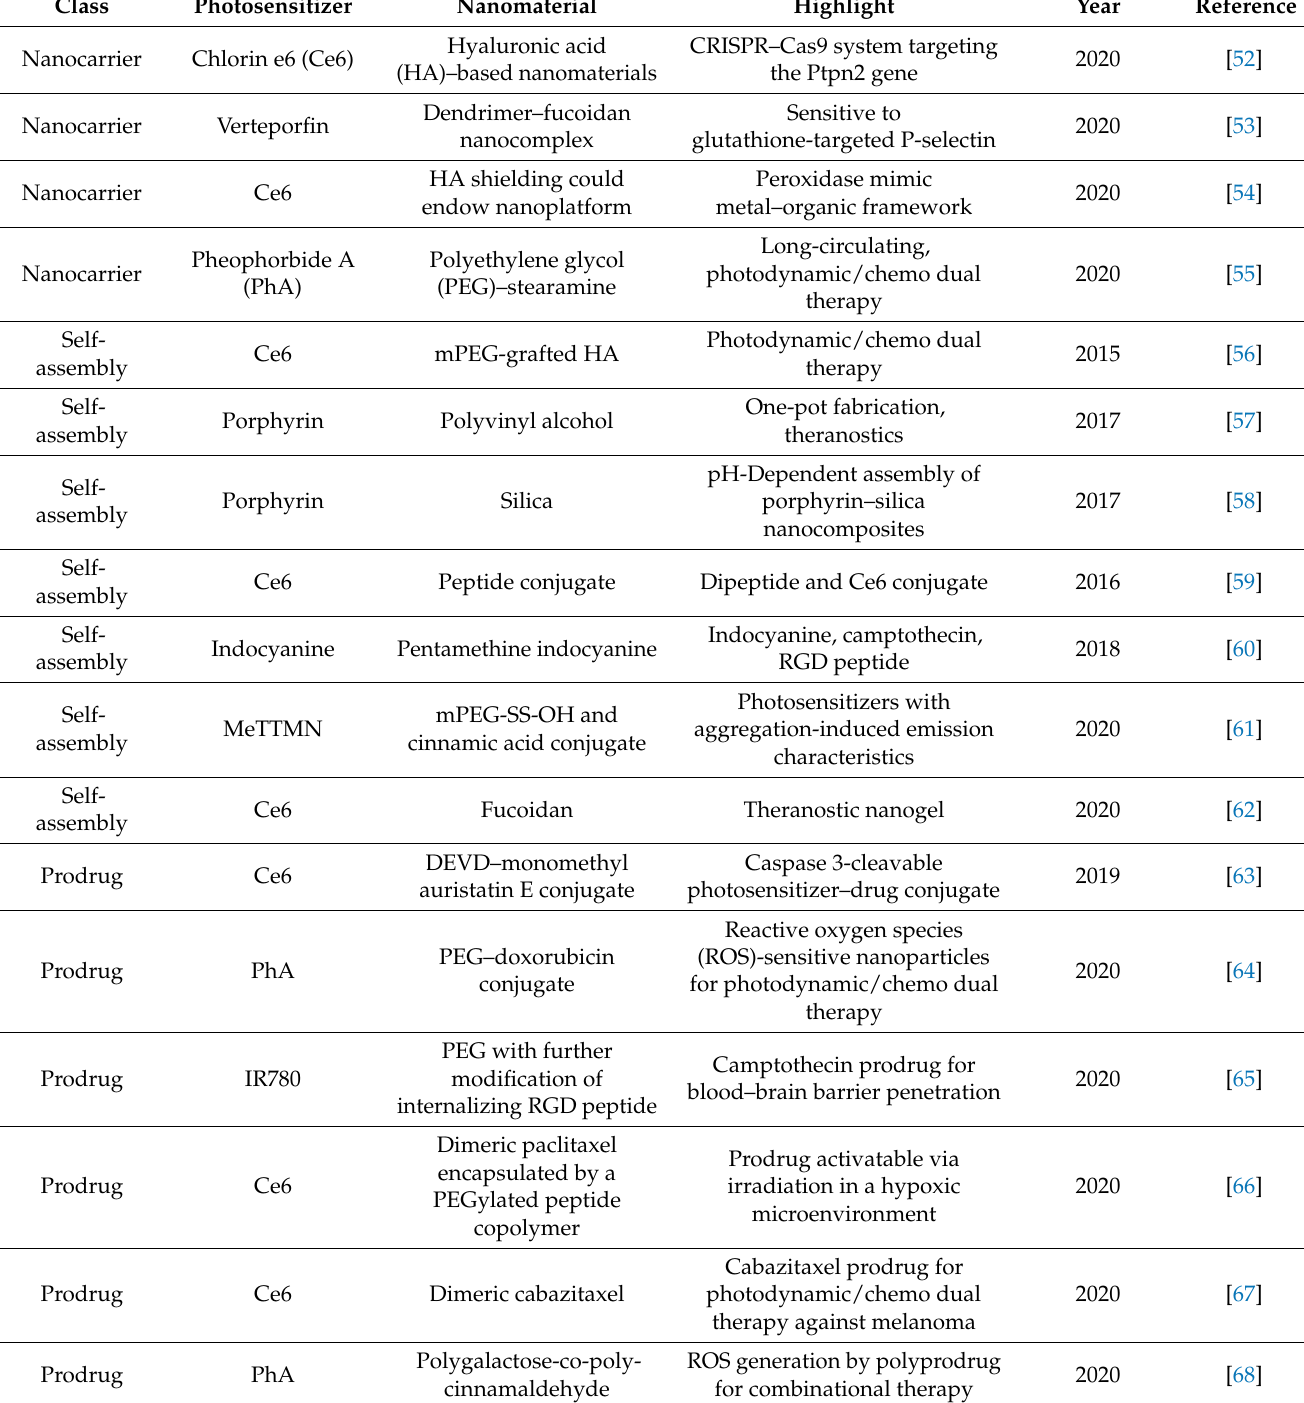
Table 2. Recent advances in preclinical developments using nanomedicine for